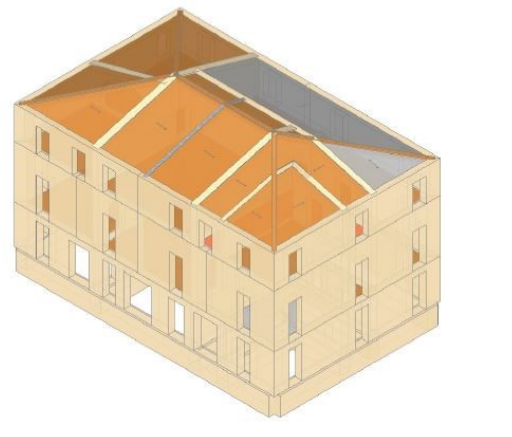
Figure 5. ( a ) 3D Finite Element model of the building; ( b ) Equivalent frame model.